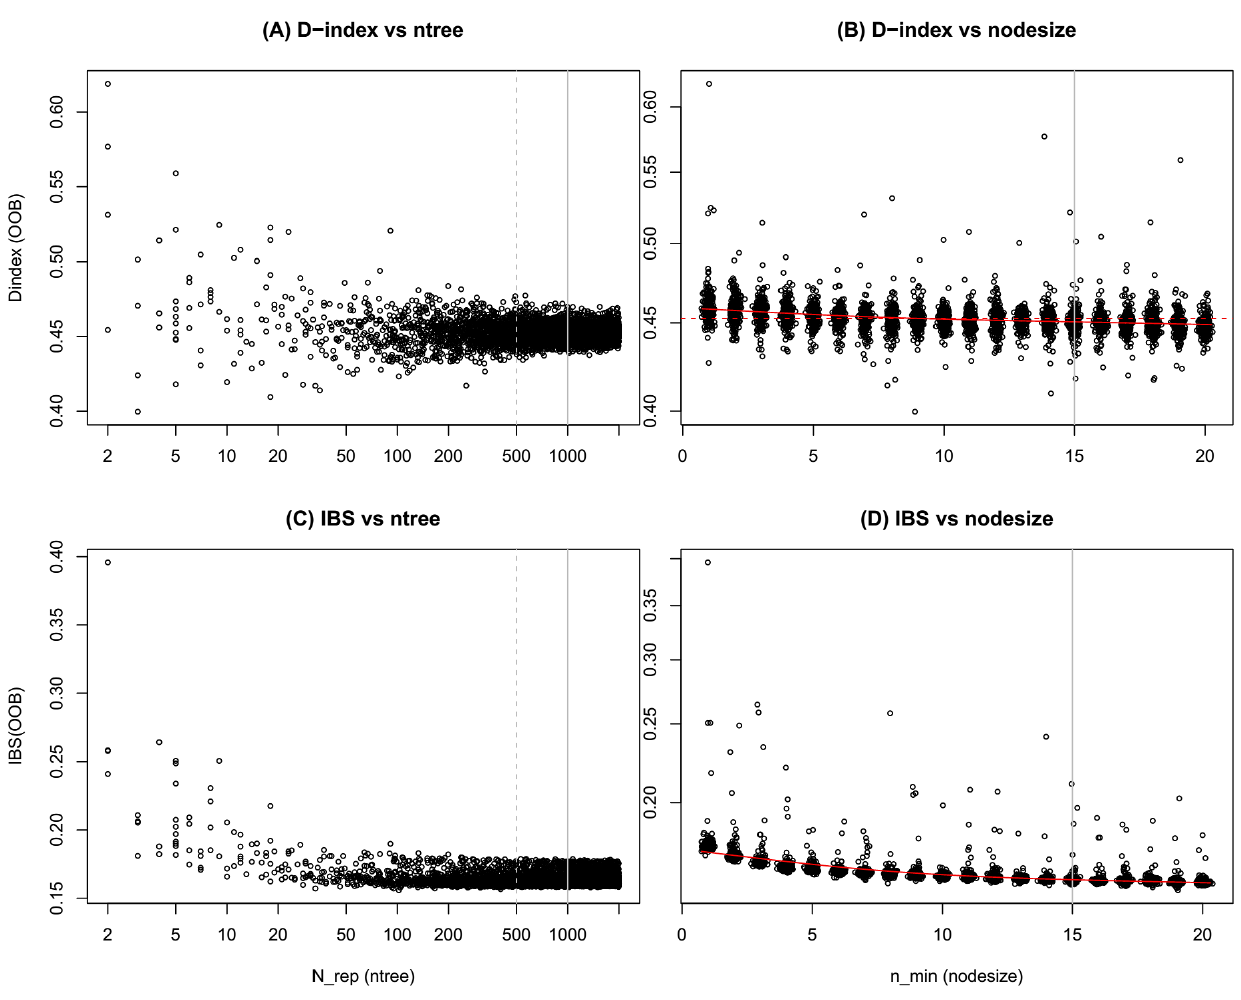
Figure 1. OOB D-index for RSF as a function of (A) number of trees ( 𝒏𝒕𝒓𝒆𝒆 ); (B) minimum (after averaging over all nodes) number of samples per node before stopping ( 𝒏𝒐𝒅𝒆𝒔𝒊𝒛𝒆 ); OOB IBS for RSF as a function of (C) 𝒏𝒕𝒓𝒆𝒆 ; and (D) 𝒏𝒐𝒅𝒆𝒔𝒊𝒛𝒆